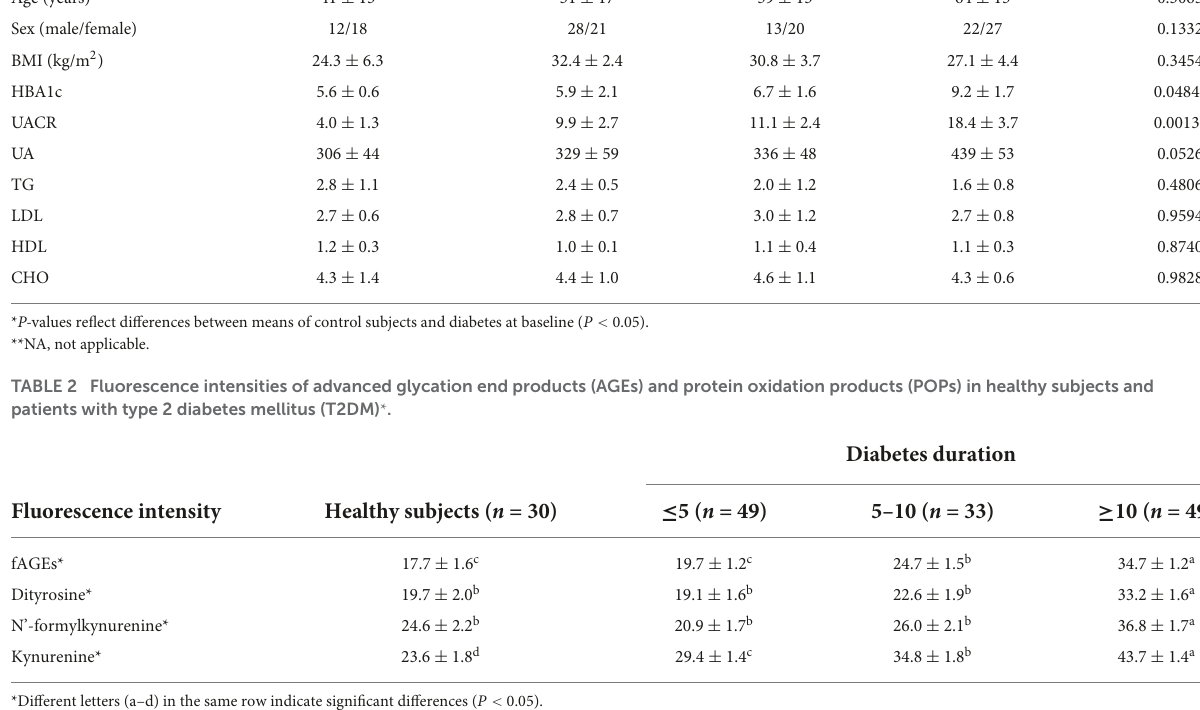
TABLE 1 Clinical and biochemical characteristics of participants.